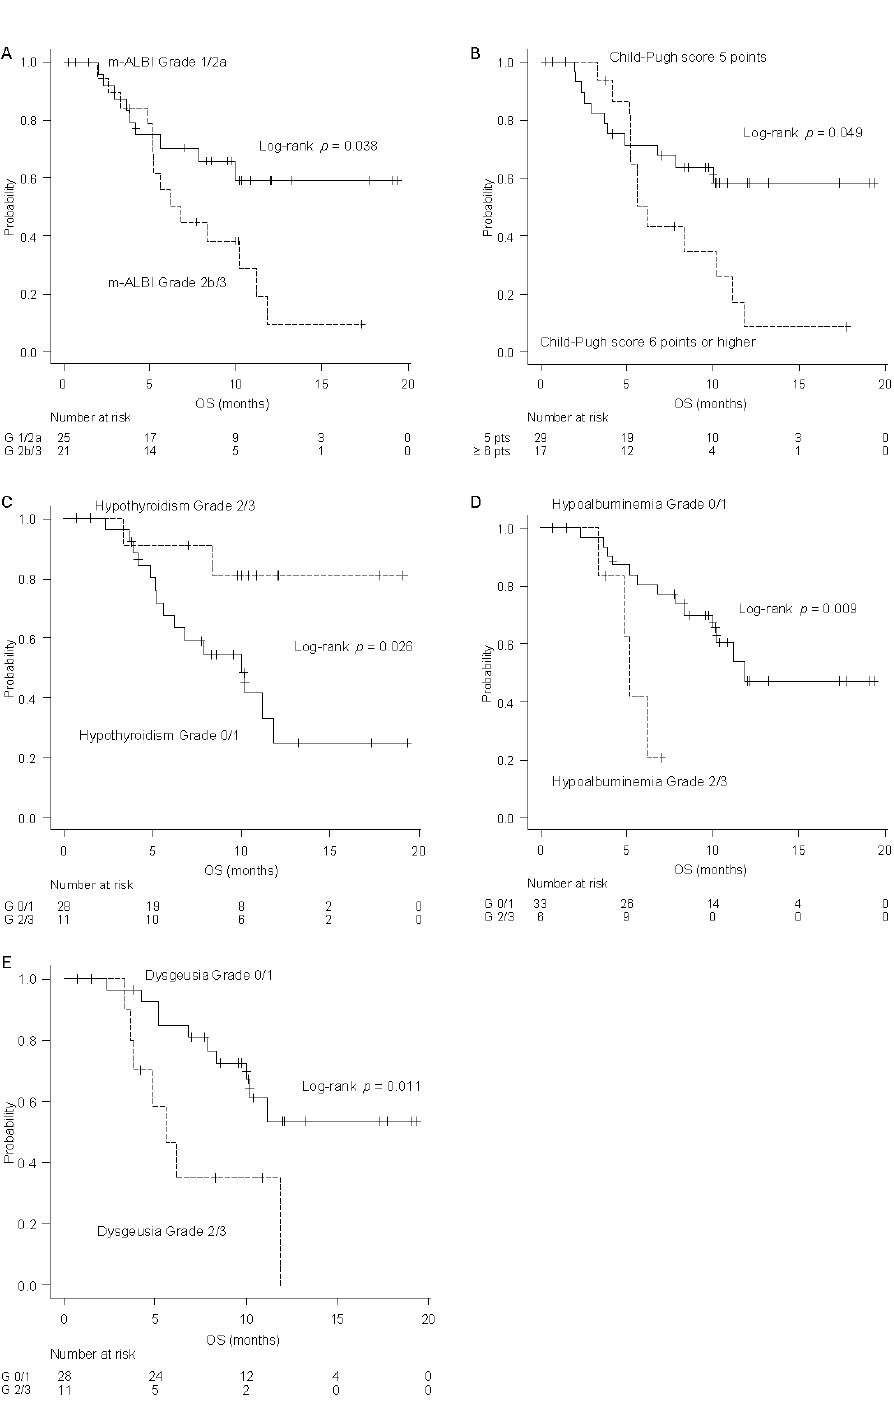
Figure 2. Factors associated with overall survival. ( A ) The relationship between modified albumin bilirubin (mALBI) grade and overall survival. ( B ) The relationship between Child-Pugh score and overall survival. ( C ) The relationship between hypothyroidism and overall survival. ( D ) The relationship between hypoalbuminemia and overall survival. ( E ) The relationship between dysgeusia and overall survival.